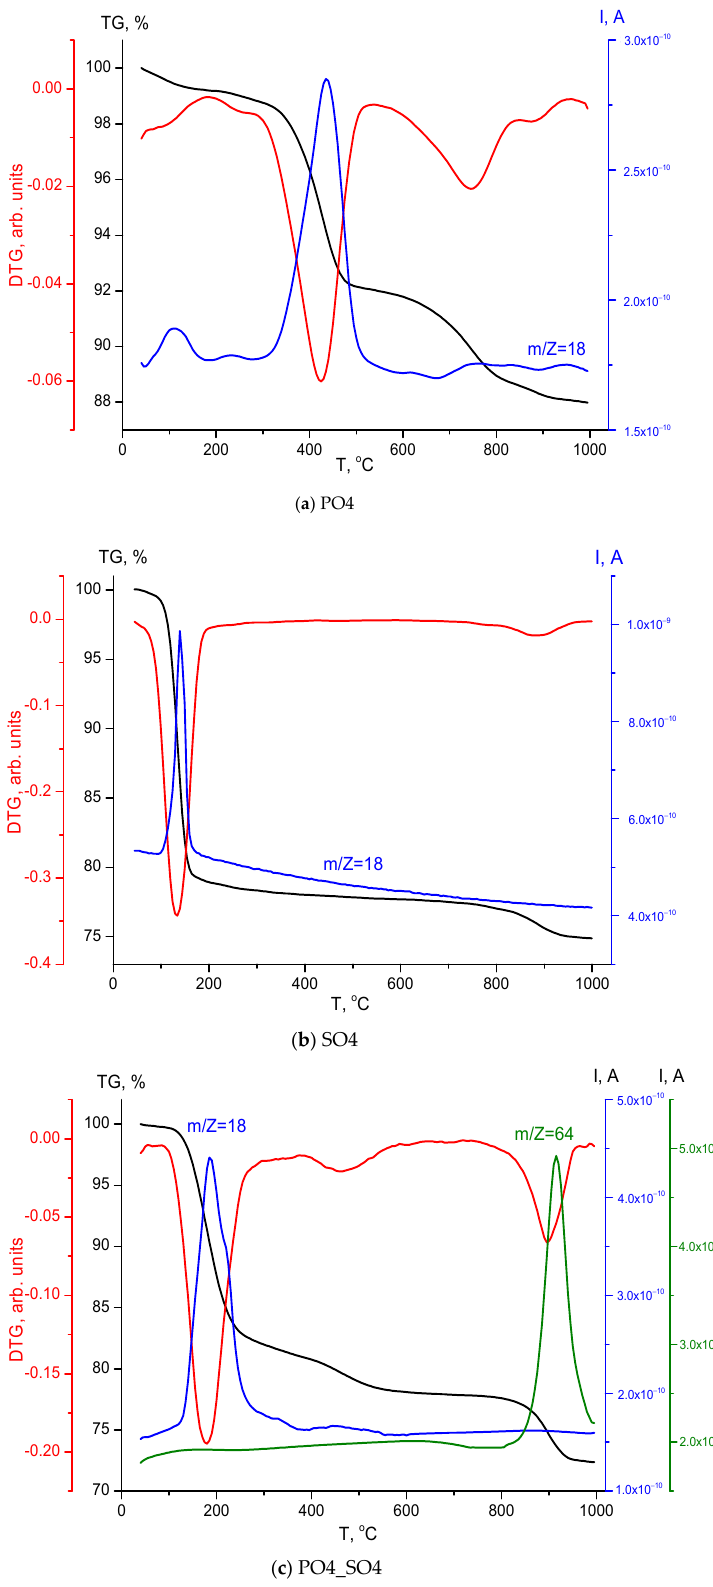
Figure 7. DTG and selected mass-spectra of powders synthesized from aqueous solution of calcium chloride CaCl 2 and sodium hydrophosphate Na 2 HPO 4 ( a ); from aqueous solution of calcium chloride CaCl 2 and sodium sulfate Na 2 SO 4 ( b ); and from aqueous solution of calcium chloride CaCl 2 and mixed-anionic solution Na 2 HPO 4 /Na 2 SO 4 ( c ) after disaggregation in acetone.